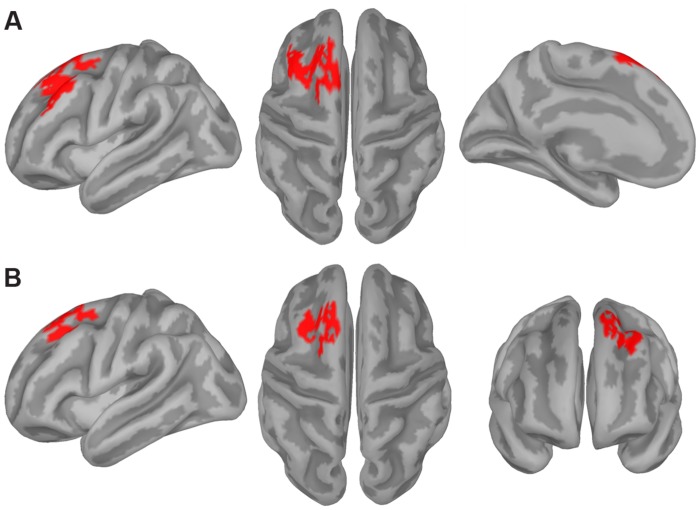
Source estimation results. The figure displays the significance mask representing the cluster of cortical sources showing a statistically significant switch effect (switch > repeat) for the frontal (A) and posterior (B) ERP switch effect as revealed by the cluster-based permutation test. This test compared the z-maps representing the estimated activity of the cortical sources in the repeat and switch conditions in the 30-ms time window corresponding to the ERP switch effects revealed by the tmax permutation test (see gray shaded area in Figures 3B,C, respectively).